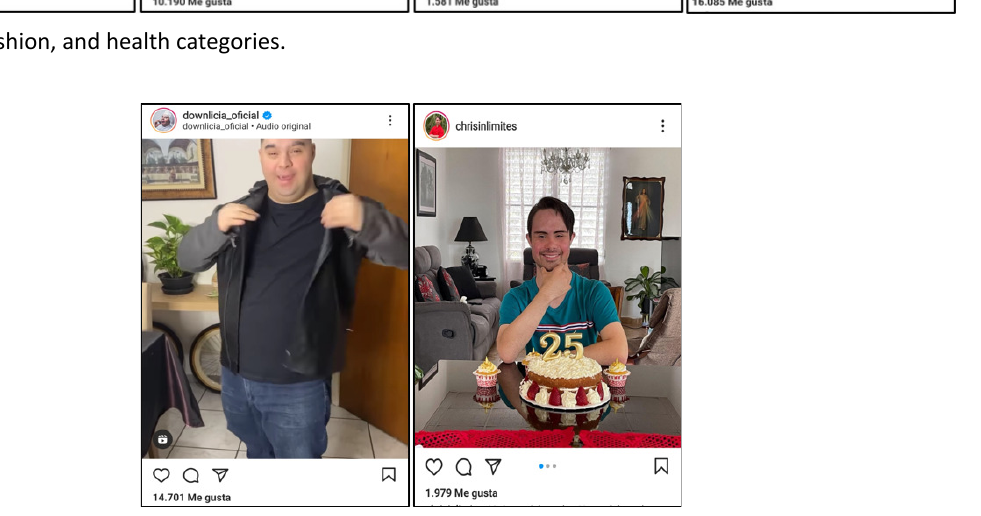
Figure 2. Entrepreneurship and gastronomy